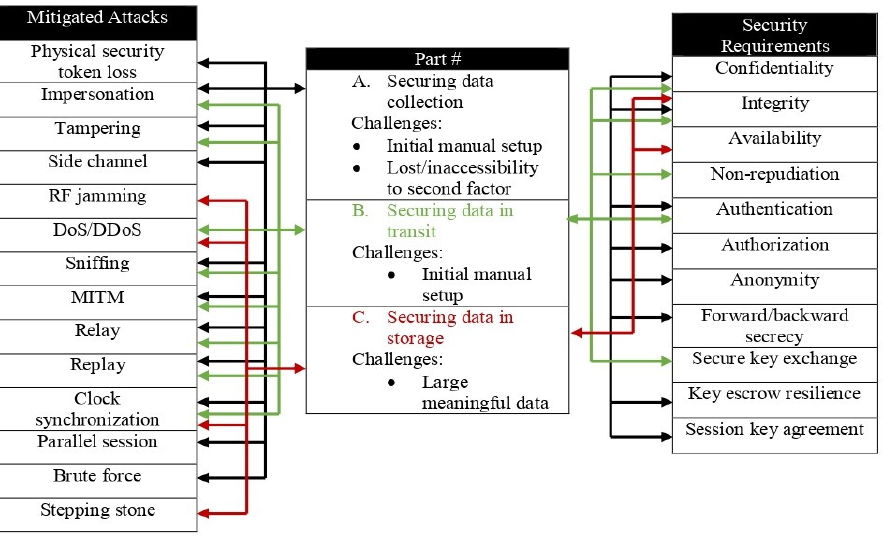
Figure 12. Framework by Ghubais with security features [60].